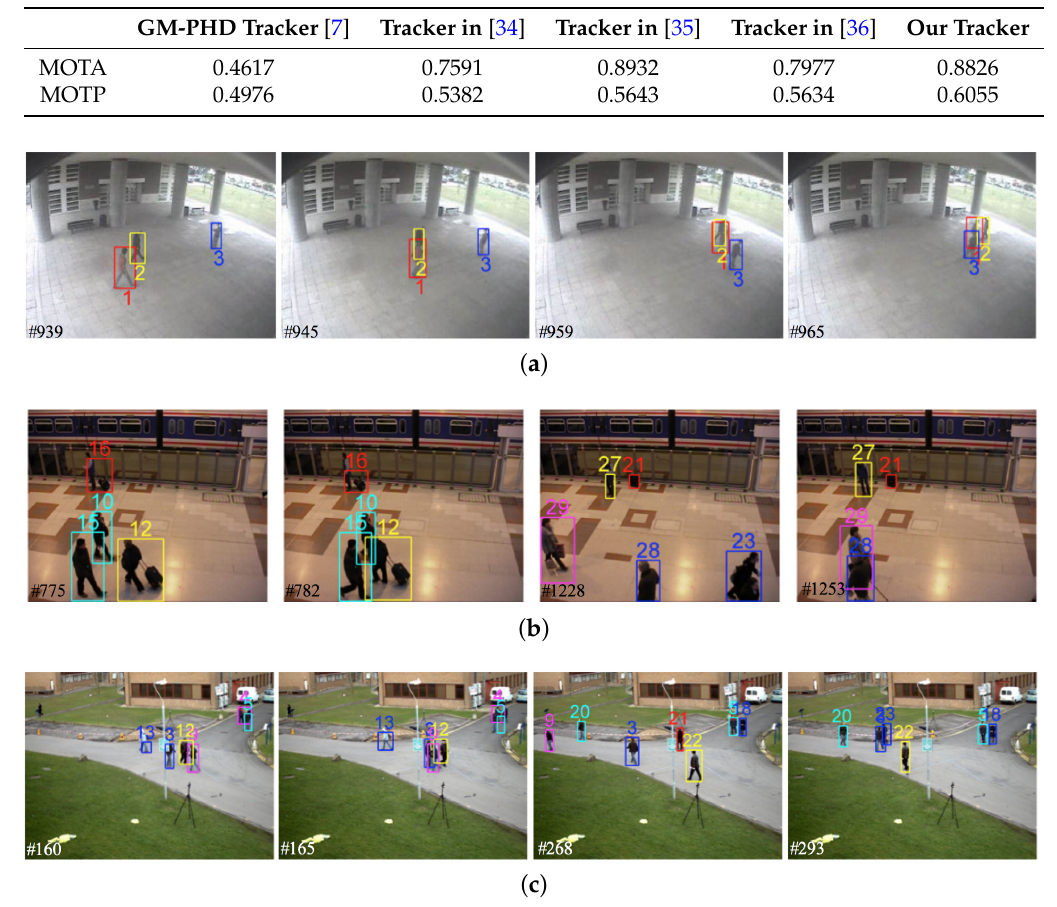
Table 4. Tracking performance comparison on the campus surveillance scenario of PETS2009.